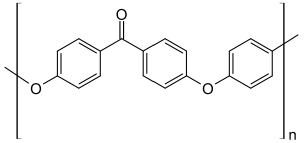
Figure 13. The chemical structure of PEEK.